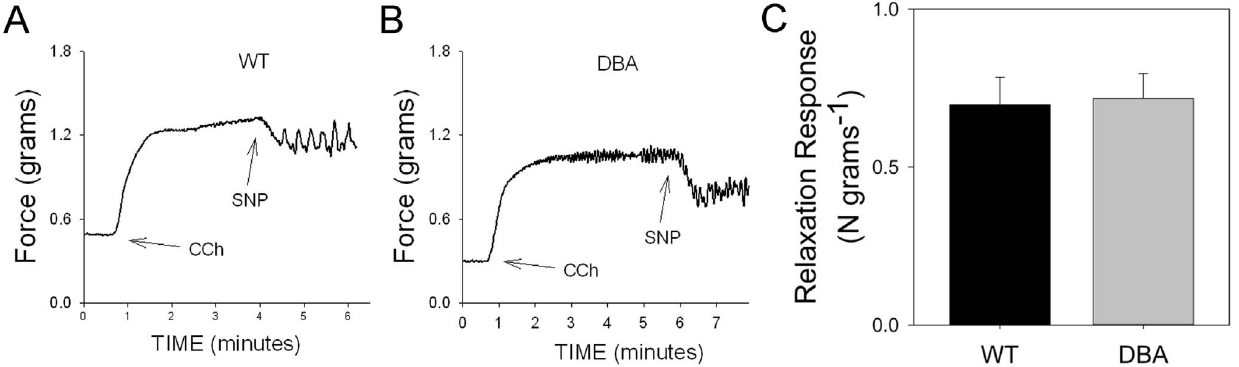
Figure 4. Effect of NO donor on contractile response. After pre-contraction with carbachol (arrows), relaxation was induced by SNP (1 m M) in WT (A) and DBA (B) fundus. (C) Graph shows that SNP induced relaxation was similar in magnitude in WT (black bars) and DBA (gray bars) mice. [n=8 in each group, p=0.433, unpaired t-test].